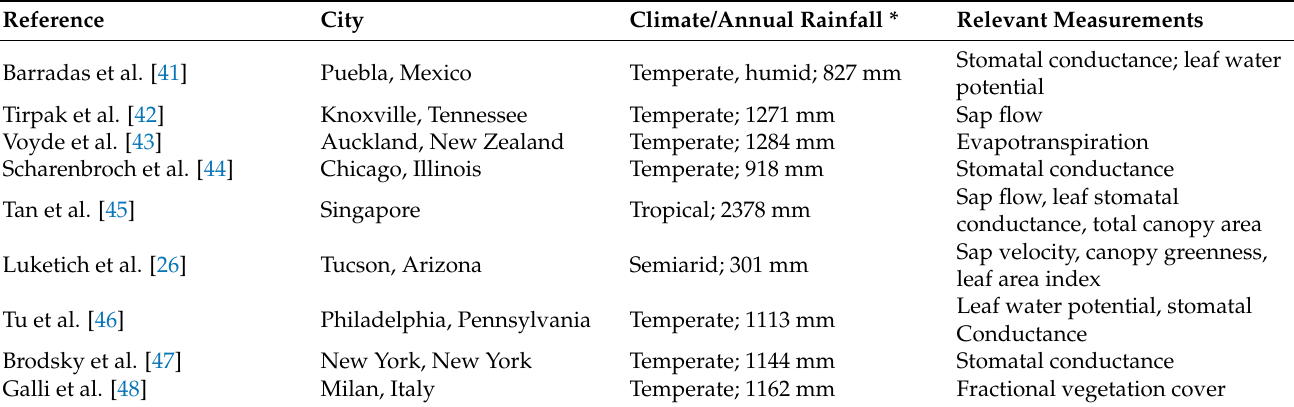
Table 1. Previous ecohydrological evaluation of green infrastructure.